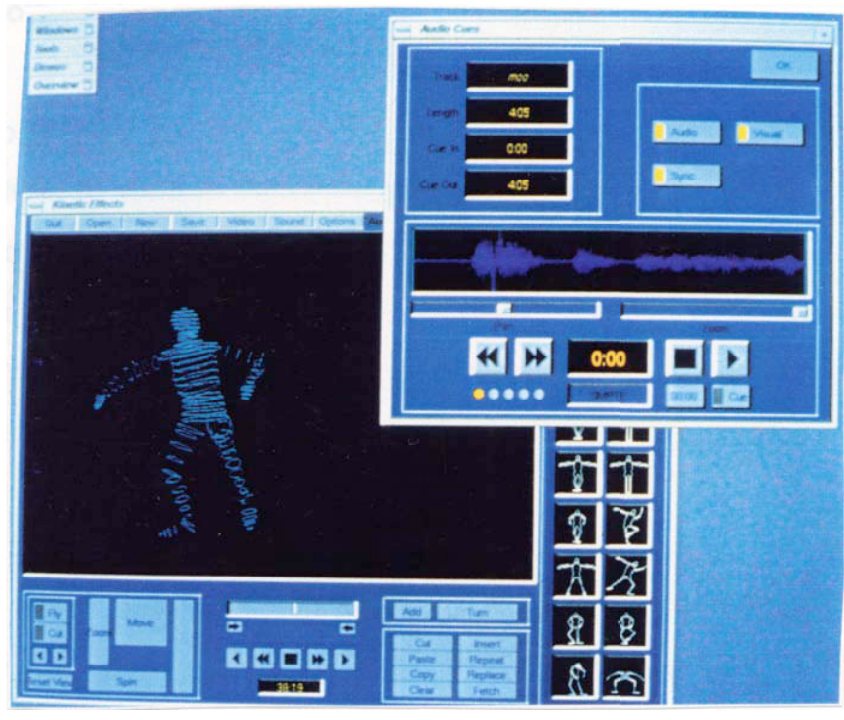
Figure 3.8 The Audio